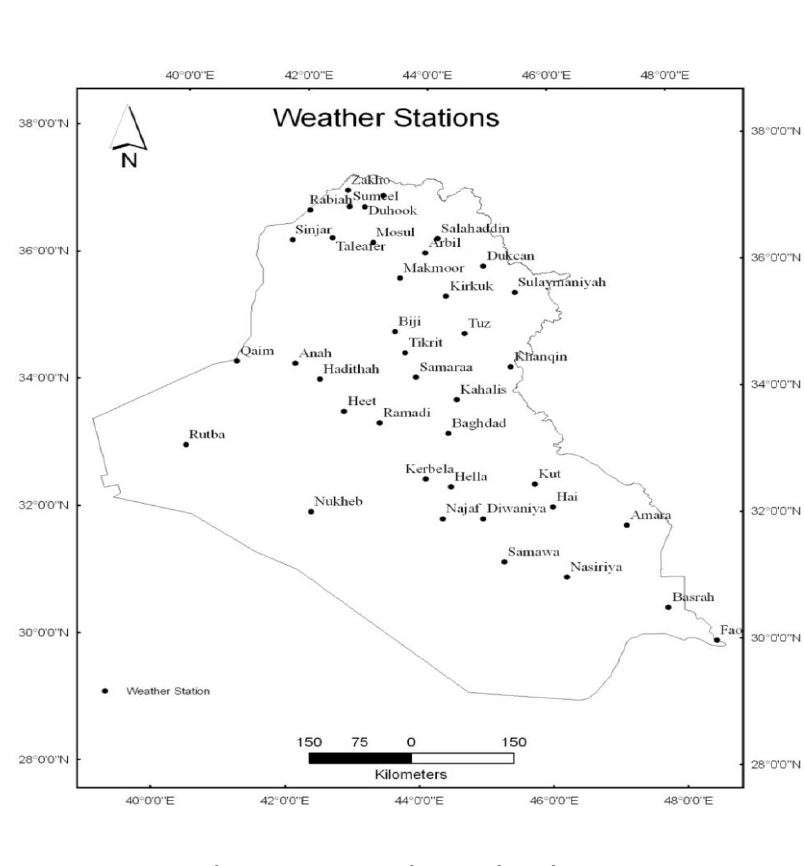
Fig. 1: Meteorological stations in